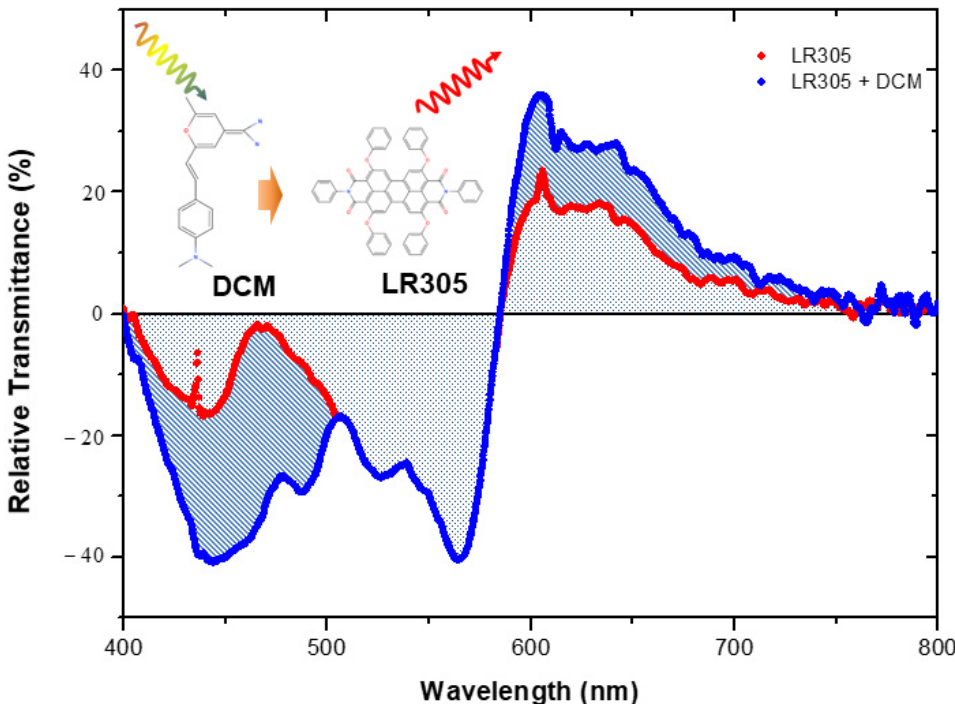
Figure 5. Normalized transmittance of the LDPE films doped with LR305 (red) and FRET system based on LR305 and DCM